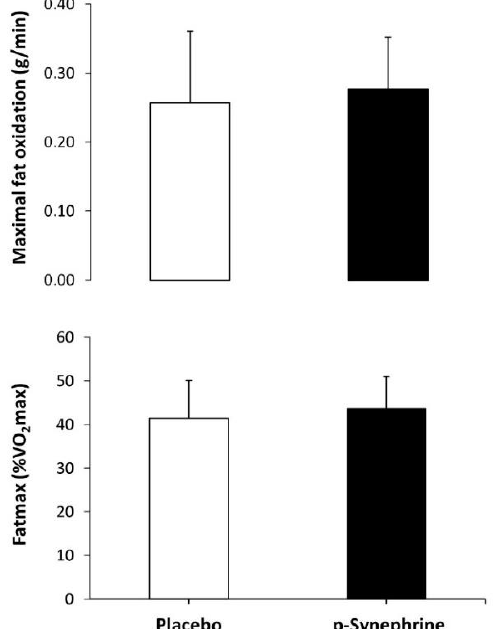
Figure 3. Maximal fat oxidation rate and exercise intensity at maximal fat oxidation (Fatmax) during exercise of increasing intensity after the ingestion of 3 mg/kg of p -synephrine or a placebo in in healthy active women.